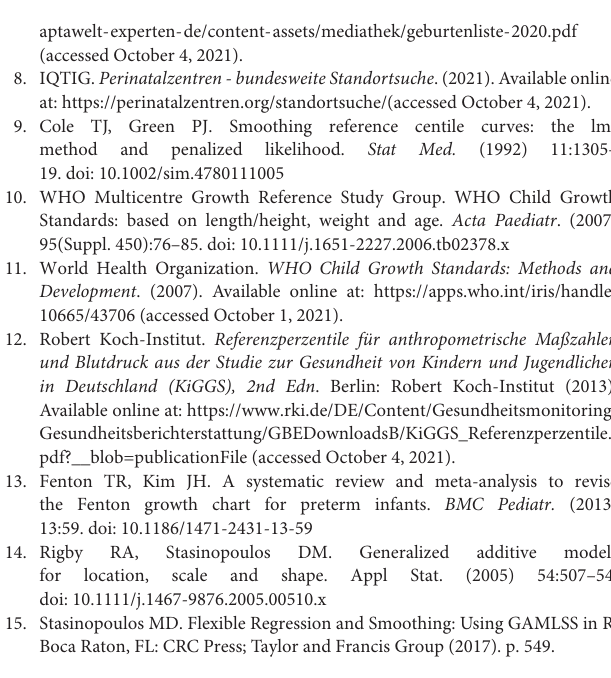
Supplementary Table 3 | LMS parameters of models of head volume index (HVI) for girls. Supplementary Table 4 | LMS parameters of models of head volume index (HVI) for boys. Supplementary Figure 1 | Plot of z-score distribution densities of excluded values versus included values. Filled red polygon shows the distribution of excluded values in its actual proportion to the included values. Supplementary Figure 2 | Gridded charts for ear-to-ear distances (EED) in relation to gestational age: transfontanellar EED (fEED), transvertical EED (vEED). Supplementary Figure 3 | Relative daily gains of the 50th percentile of occipitofrontal circumference (OFC), transfontanellar EED (fEED), and transvertical EED (vEED). Supplementary Figure 4 | Relative differences between the 50th percentiles of our new models and the corresponding percentiles by Voigt et al. and Fenton and